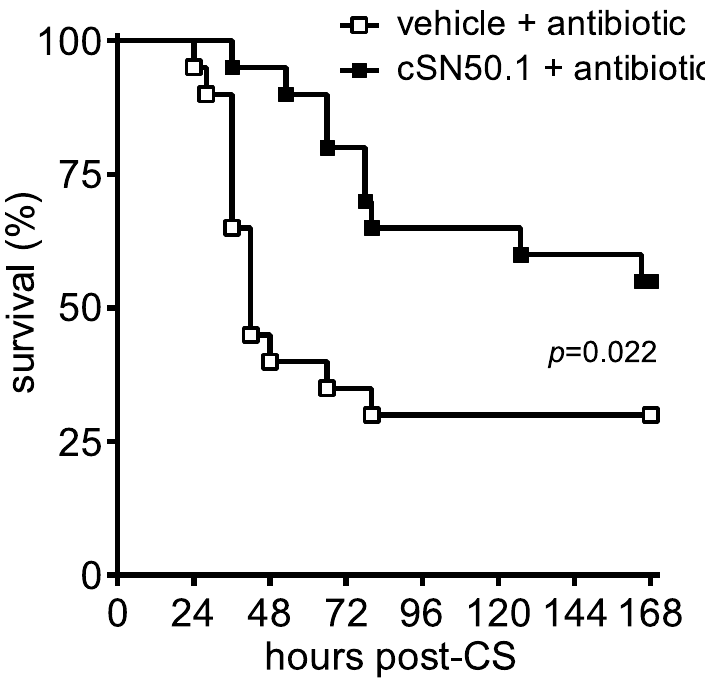
Fig 5. Survival is increasedby combining NTM treatment with antibiotic therapy. Mice were infected with CS and treated with vehicleor NTM (cSN50.1), both supplemented by antibiotictherapy with meropenem ( n = 20 mice/group; Kaplan-Meier survival plot with p value calculatedby log rank analysis).